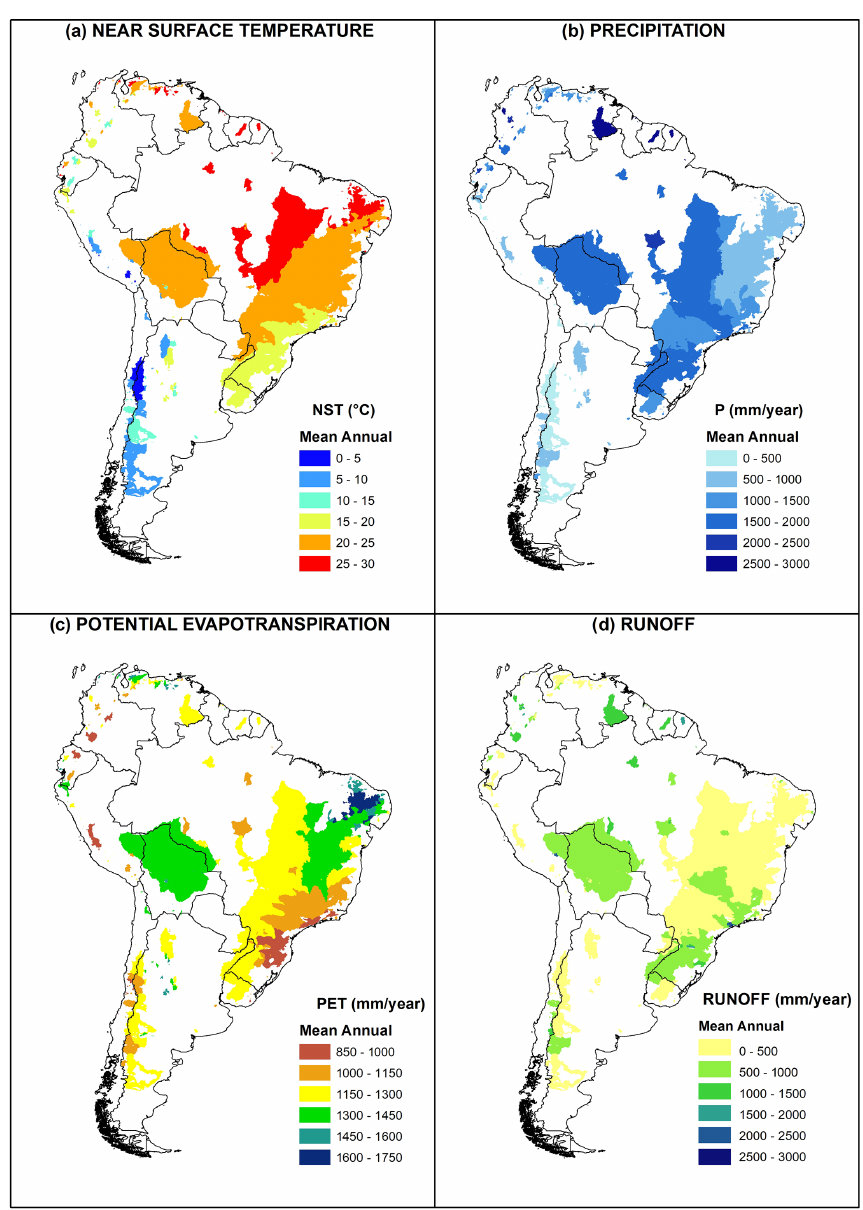
Figure 3. (a) Near-surface temperature, (b) precipitation, (c) potential evapotranspiration and (d) runoff maps for each dam’s